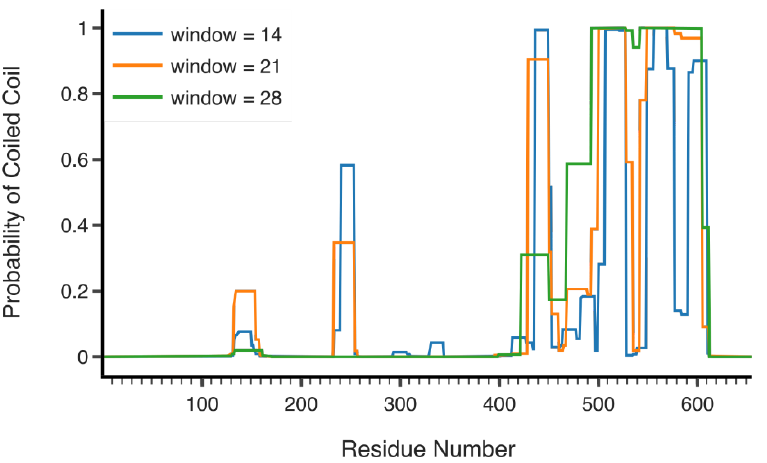
Figure 5. COILS prediction of RLIP76. Plot of predicted coil coiled regions in RLIP76 by COILS server. Window size is the number of amino acids in the sliding window the server uses across the sequence. The resolution between globular and coiled-coil score distributions decreases strongly with decreasing window size. However, ends of coiled coils and short sections can be identified with smaller windows.